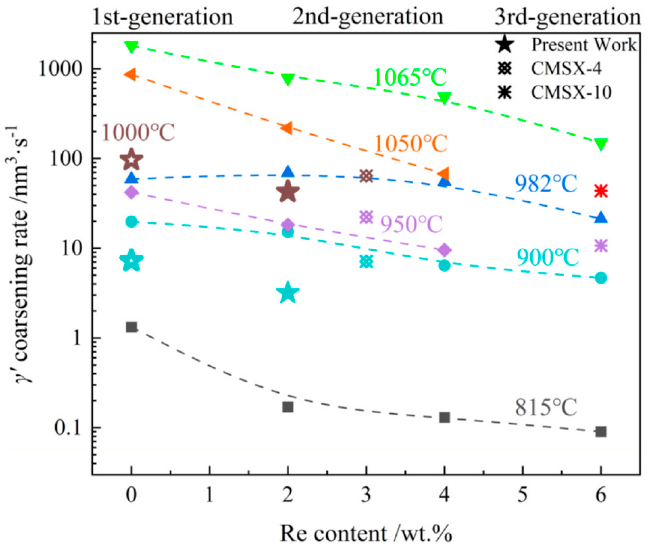
Figure 14. γ′ coarsening rate as a function of Re content at various temperatures [57]. (Different types of symbols indicated the data is extracted from different works.)